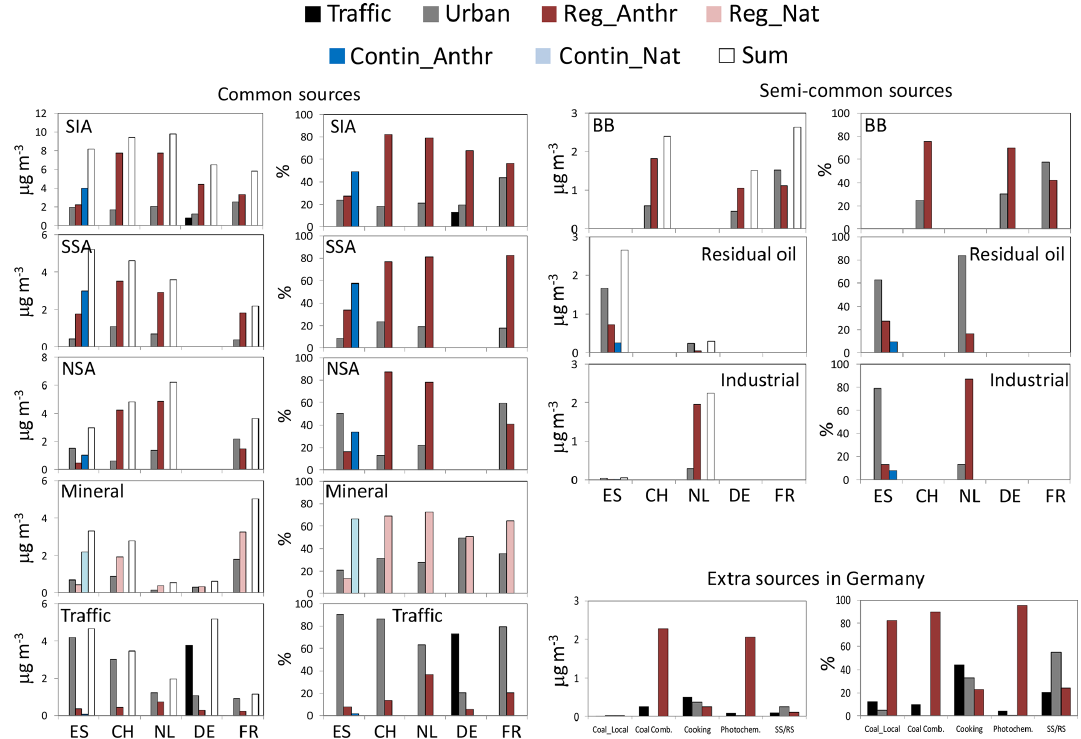
Figure 6. Lenschow’s approach applied to the PM 10 (PM 2 . 5 in the Netherlands) PMF source contributions. Annual means are reported. ES: Spain; CH: Switzerland; NL: the Netherlands; DE: Germany; FR: France. In all countries, with the exception of Spain, Reg_Anthr and Reg_Nat are the sum of the regional and continental increments.